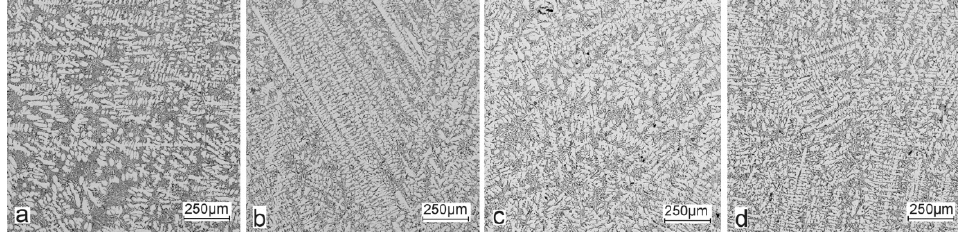
Figure 6. Microstructure of AlSi10 alloy with Sn addition—mag. 50×: ( a ) AlSi10; ( b ) AlSi10Sn0.2; ( c ) AlSi10Sn0.4; ( d ) AlSi10Sn0.7.